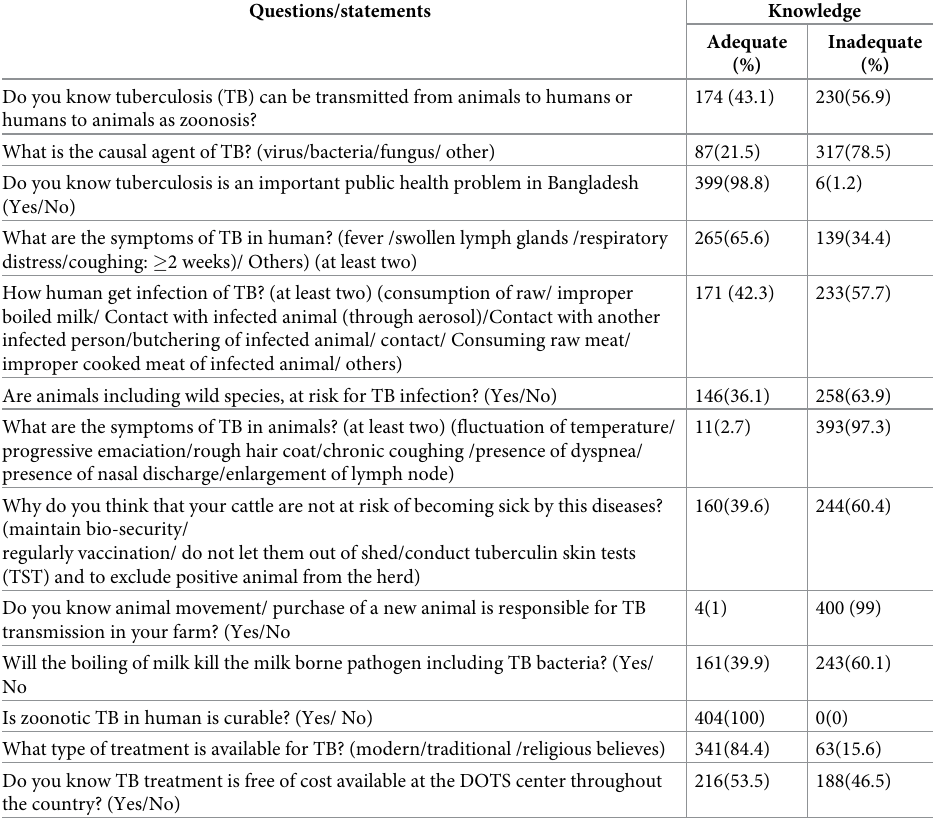
Table 3. Summary responses for cattle handlers’ knowledge with respect to zoonotic tuberculosis in the selected districts of Bangladesh (N = 404).